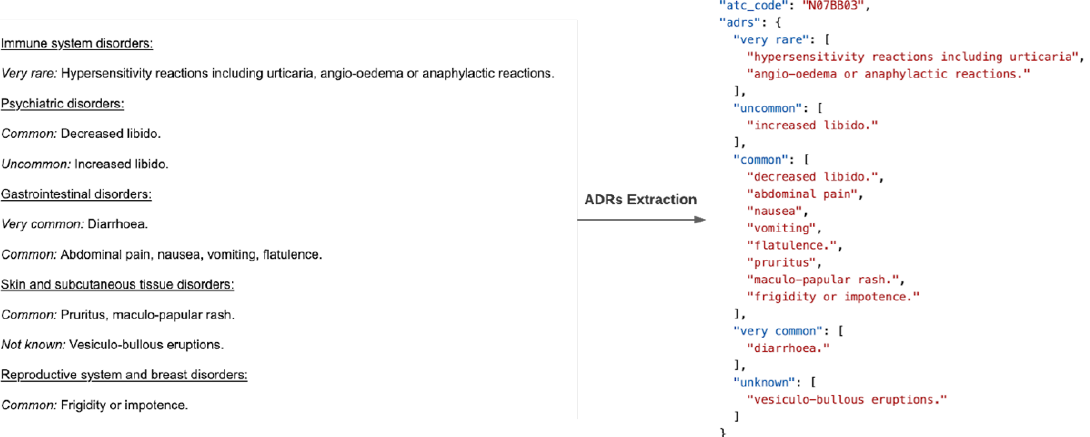
Figure 6. An example of ADR extraction for the structured text.